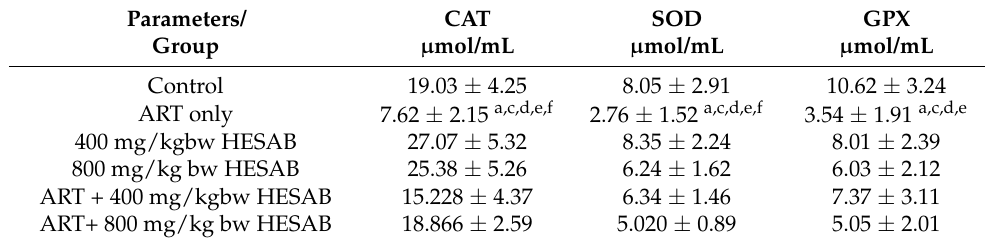
Table 3. Effects of HESAB on serum antioxidant enzymes in Wistar